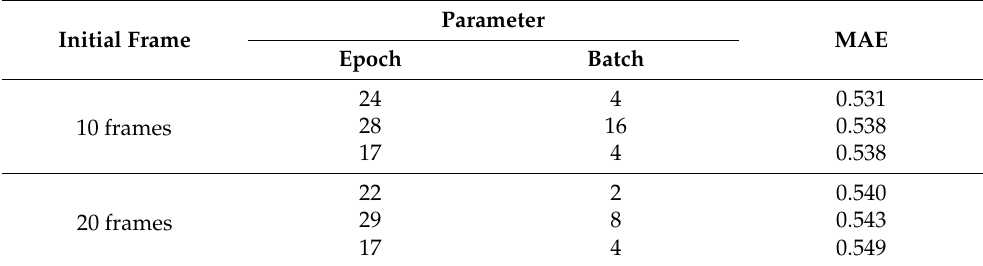
Table 3. Top three results of user-satisfaction prediction of MLP model using initial